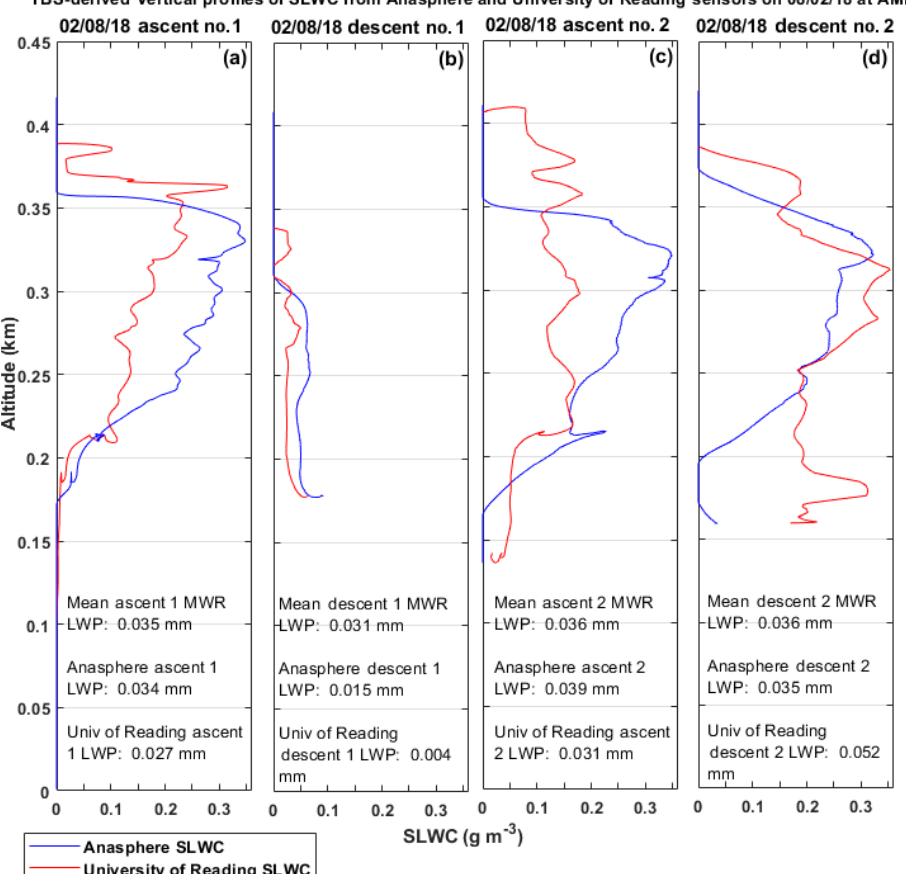
Figure 10. Vertical profiles of Anasphere and Reading SLWC from 02 August 2018 TBS flight with mean surface-based MWR LWP